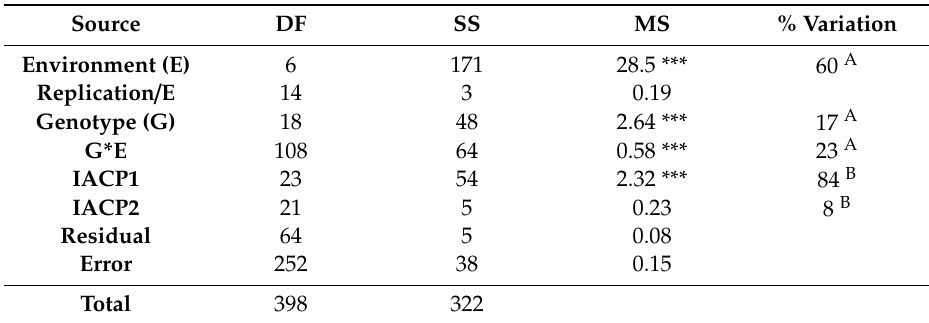
Residual Error 252 0.15 Total 398